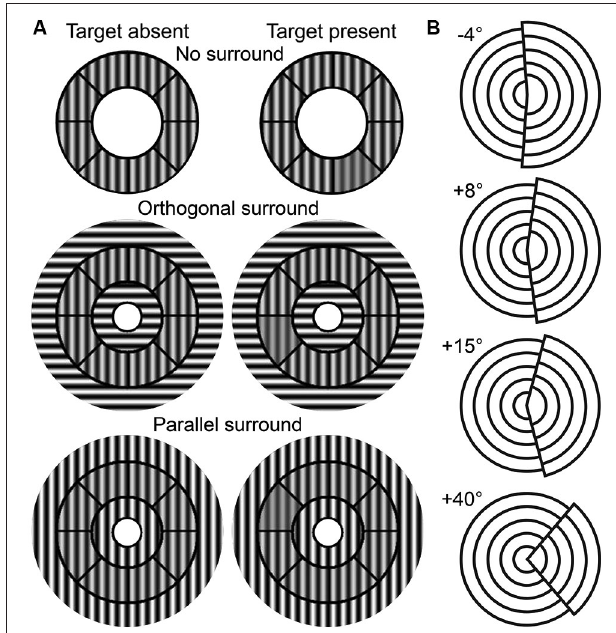
FIGURE 1 | Task stimuli . (A) OSSS task stimuli as a function of target presence and surround condition. (B) TAE task stimuli examples.